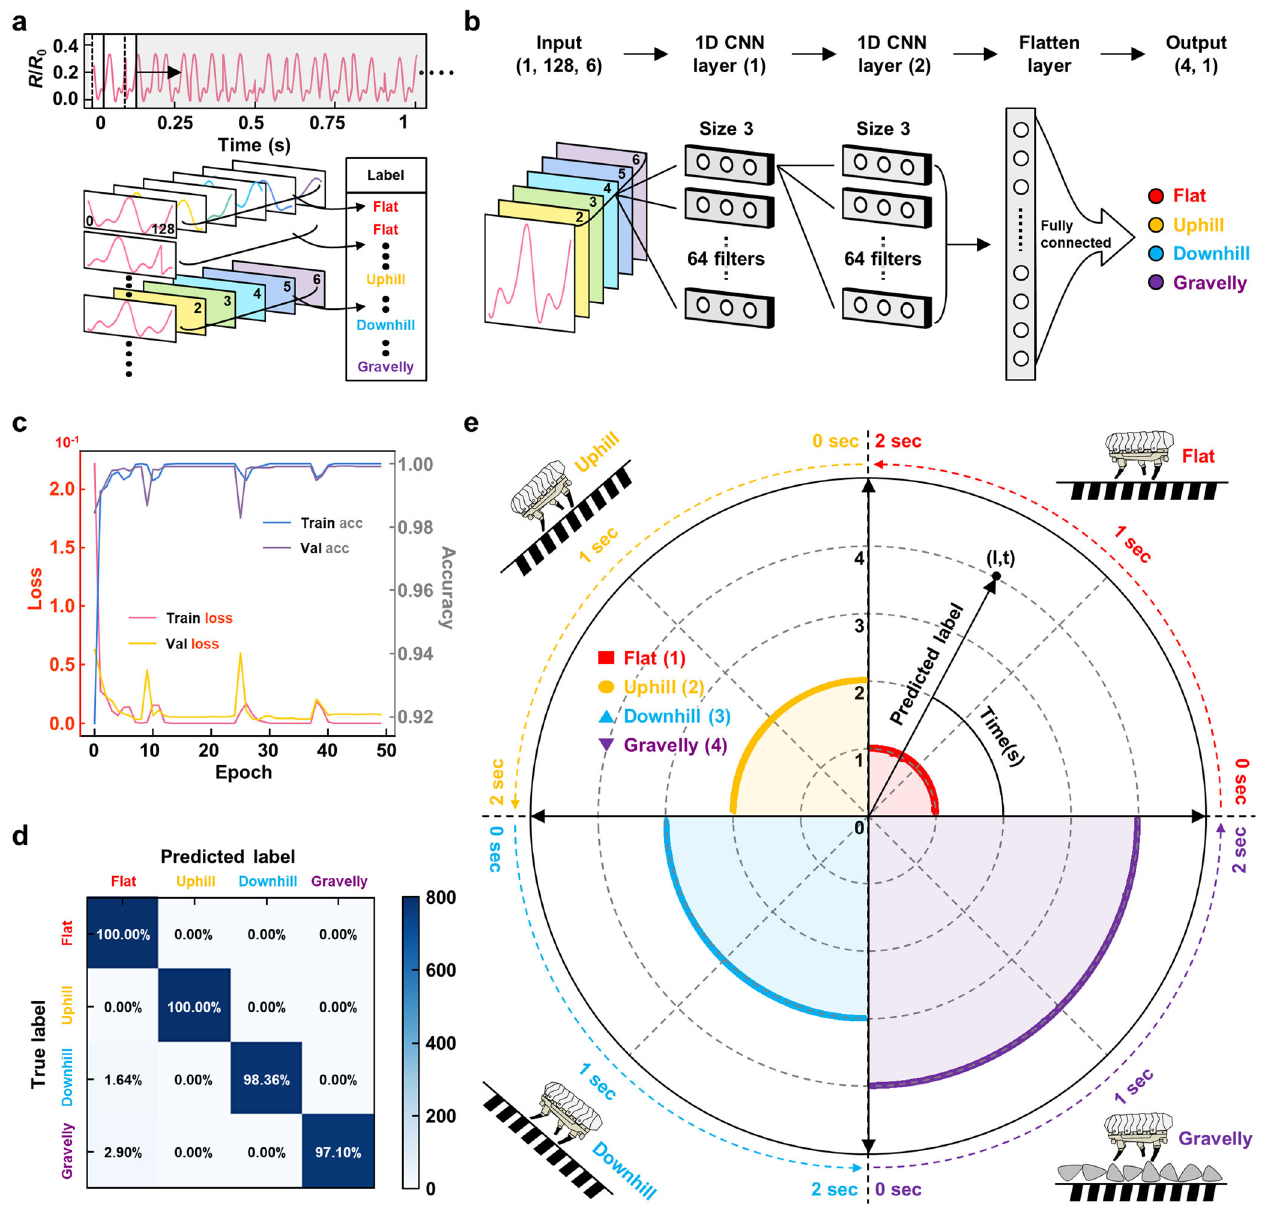
Fig. 5 Terrain type classi fi cation by machine learning. a Pre-processing of raw ULTMAC sensor data. The data was sliced and labelled into true label of each terrain. b Overveiw procedure of machine learning of 1D-CNN model when pre-processed data is fed into as input. As an output, the model classi fi es one of the terrain types. c Training result by the number of epochs. Loss value decreases while accuracy increases. d Confusion matrix from prediction of test dataset. Average accuracy is 98.86. e Terrain prediction of a trained model in polar coordinates. Time fl ows in un-clockwise. Length of radius refers to the predicted label. True label of 1 refers to fl at, 2 to uphill, 3 to downhill, and 4 to gravelly